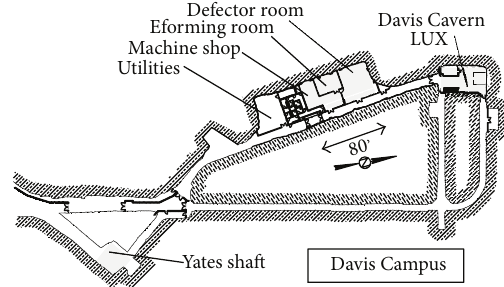
Figure 10: The layout of the Davis Campus at SURF showing the three Majorana labs and the location of the LUX experiment at the Davis Cavern. The corridor that joins the two projects is a clean